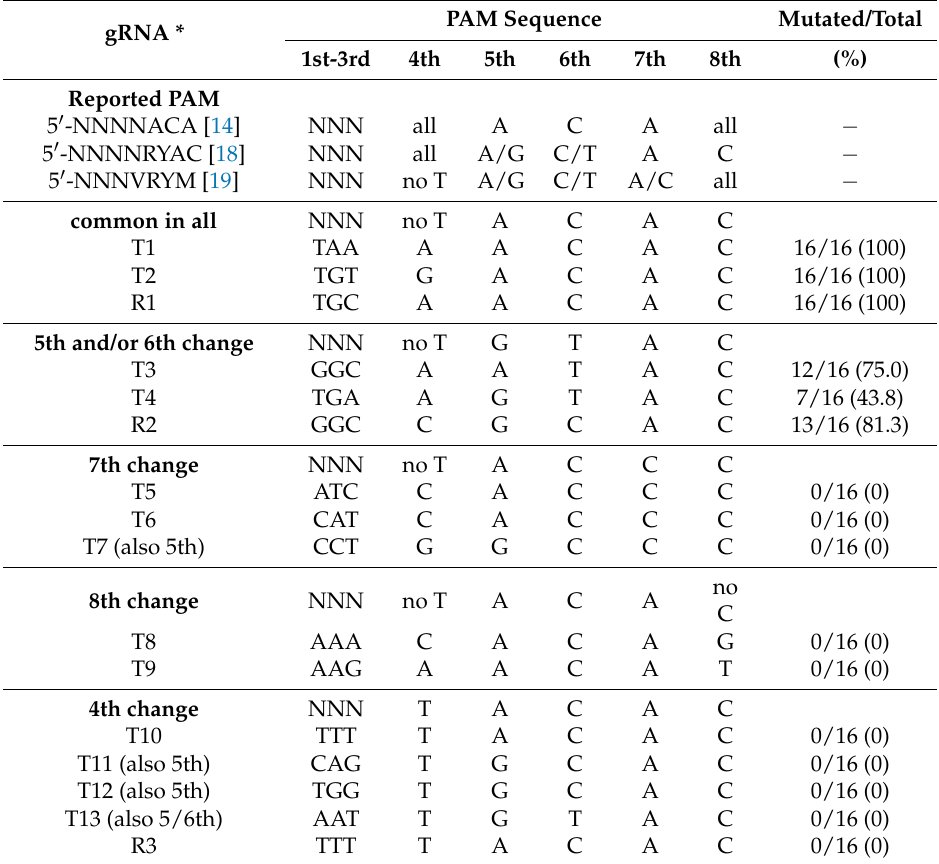
* Target sequences and schematics of designed loci are shown in Figure